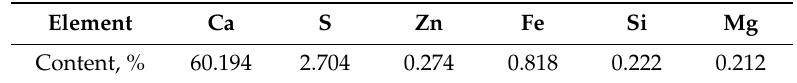
Table 1. XRF mineral elements of limestone. Table 2. Mineral composition of limestone.